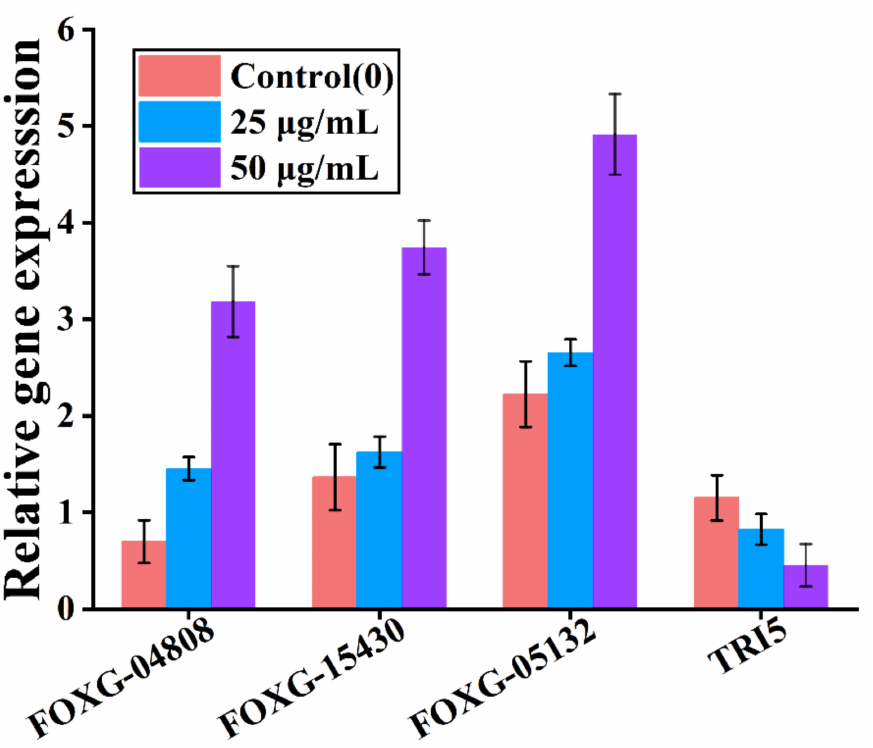
Figure 8. Quantitative reverse transcription PCR verification of the differential genes in F. oxysporum following treatment with 25 and 50 µ g/mL iturin